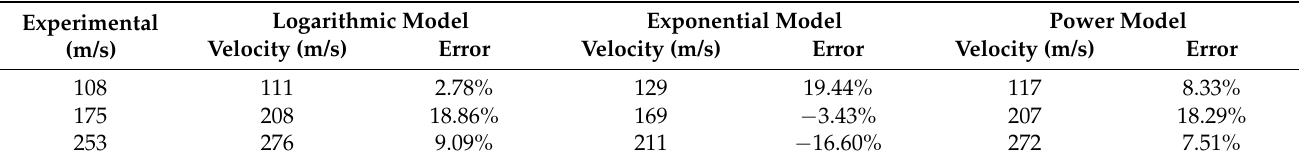
Figure 4. Crack propagation length curves and propagation of cohesive element contours of average crack tip speed of ( a ) 108, ( b ) 175, and ( c ) 253 m/s. Table 3. Average speed errors between experiment and different models.